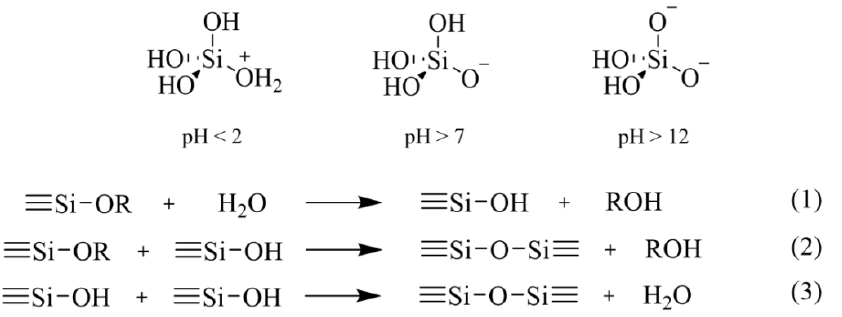
9 of 41 Figure 7. ( A ): General synthetic pathway to PMOs [22]. Reprinted with permission from [22]. Cop- yright 2006, John Wiley and Sons. ( B ): Representative bridged silsesquioxanes [25]. Reprinted with permission from [25]. Copyright 2008, American Chemical Society. Nevertheless, bridged polysilsesquioxanes featuring a wide range of bridging groups have been prepared. In 1999, three research groups independently reported on mesopo- rous organosilica hybrids from bisilylated precursors baring methyl or ethyl groups as organic bridges [23,24,26]. After that, several PMOs were prepared featuring ethylene, ethenylene, phenylene and thiophene as R groups. Rigid unsaturated precursors able to form weak interaction, such as  can self-assemble in the synthesis mixture. When hy- drolysis/condensation take place, this order can be preserved and layered “crystal-like” structural sub-domains can be included in the final PMO-type materials. The first materi- als featuring 1,4-phenylene bridges was prepared in 2002. Upon varying the size of the R bridged unit, materials featuring layers of different width were obtained (5.6–11.9 Å ) [27]. Building upon these early studies, a variety of organic groups, ranging from hydrocarbons and heteroaromatics to metal complexes, have been successfully incorporated into PMO hybrids (Figure 7B) [22,25,28].